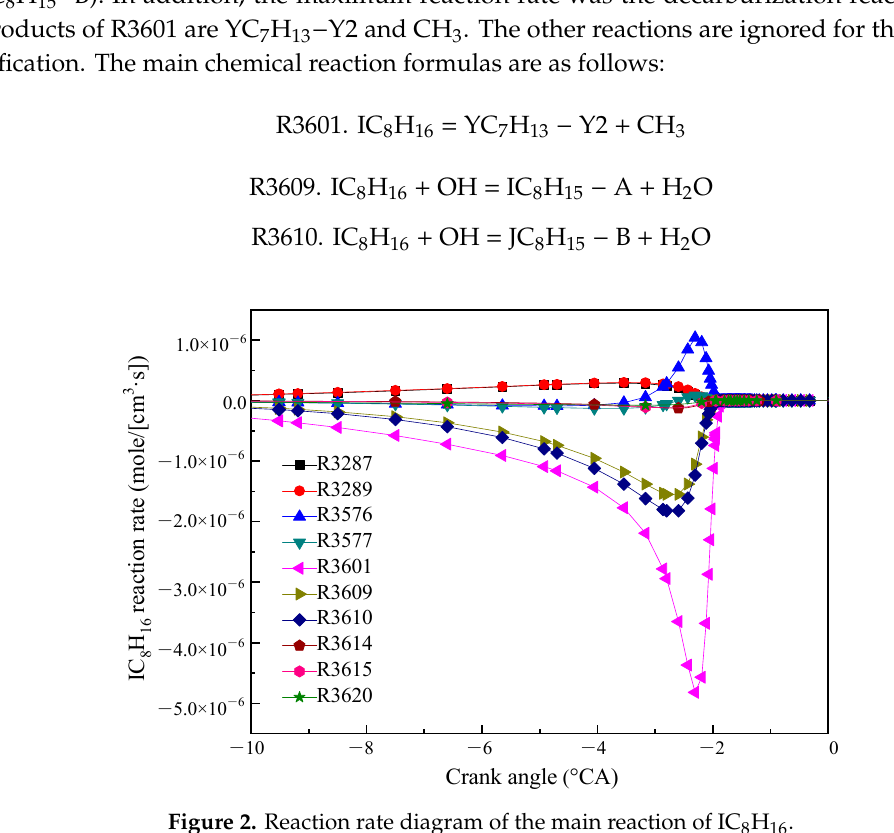
Figure 2. Reaction rate diagram of the main reaction of IC 8 H 16 .